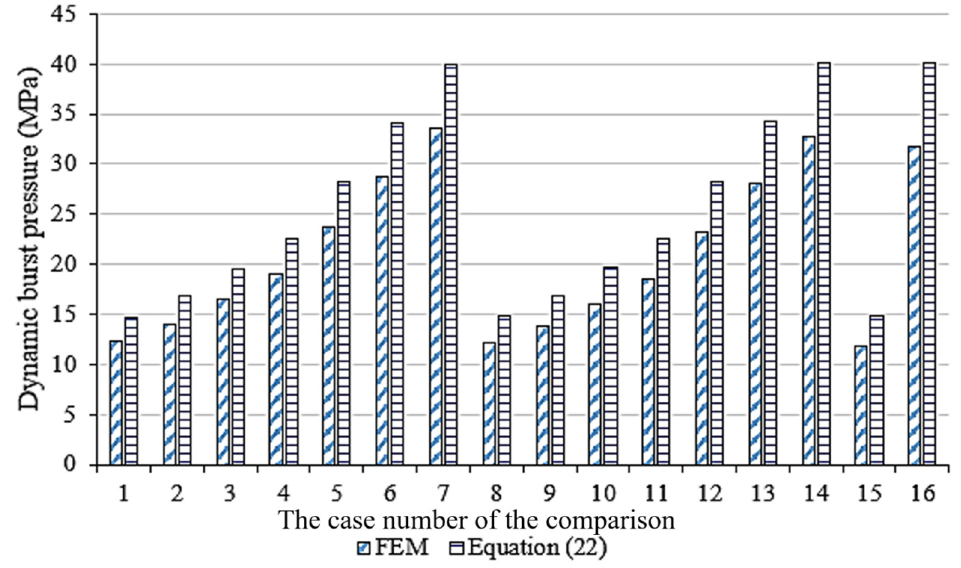
Figure 6. Comparisons between the FEM results and Equation (22), when t d = 3.9 ms.